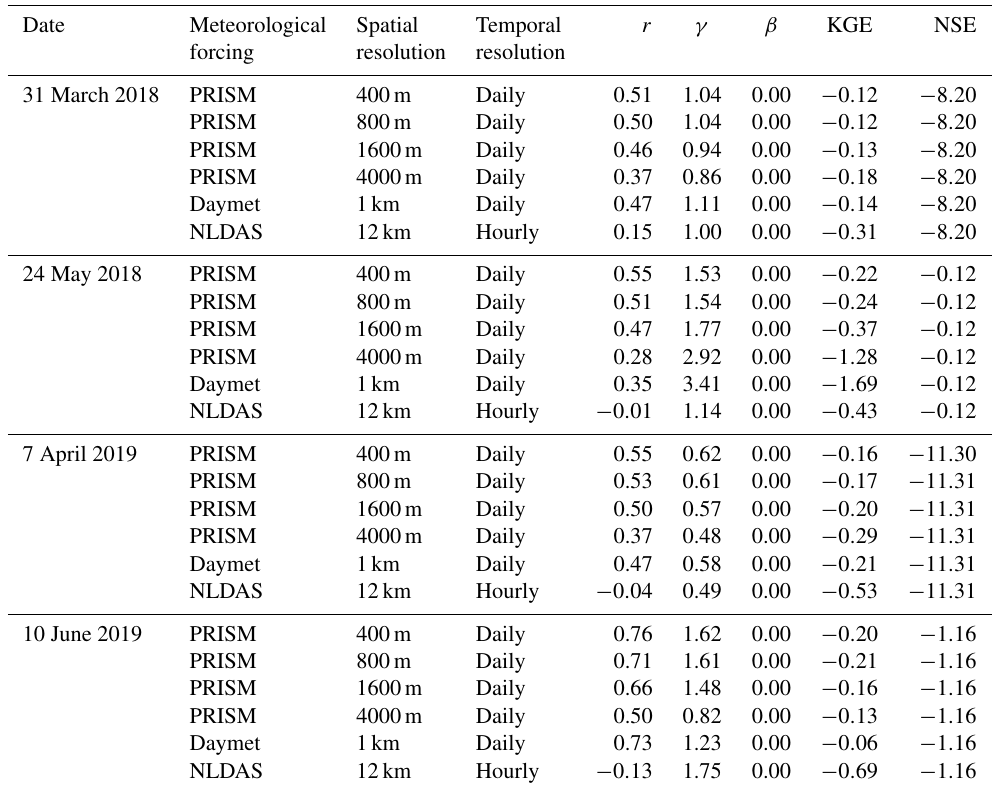
Table 4. Summary of statistical metrics used for evaluation of spatially distributed SWE under different meteorological forcings at different times compared to observed SWE from